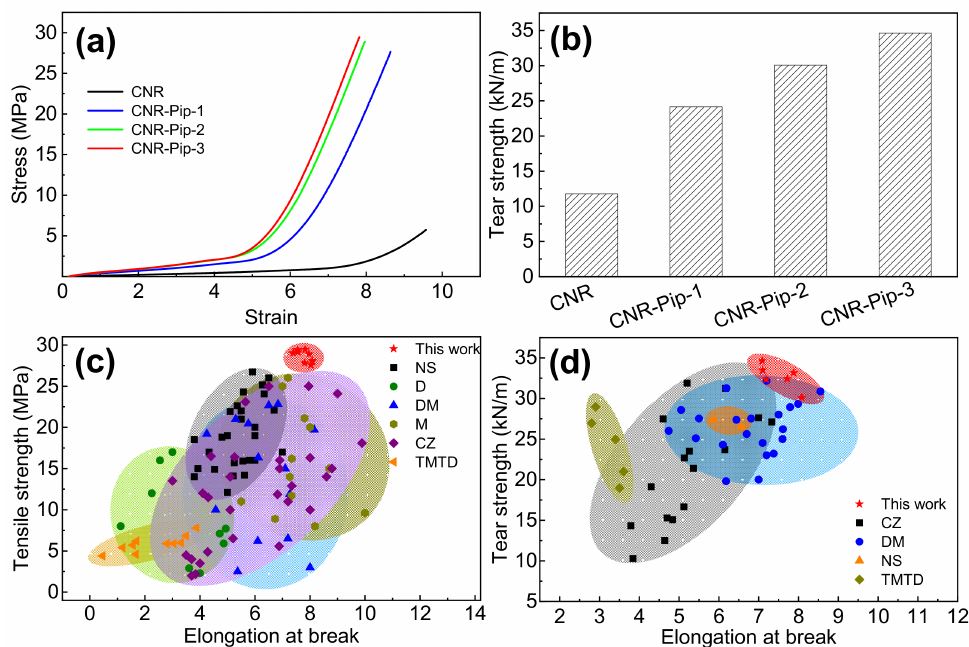
Figure 4. Changes in mechanical properties upon the addition of phase transfer agent. ( a ) Stress– strain curves of CNR, CNR-Pip-1, CNR-Pip-2, and CNR-Pip-3. ( b ) Tear strength of CNR, CNR-Pip-1, CNR-Pip-2, and CNR-Pip-3. ( c ) Comparison of tensile strength and elongation at break among this work and the elastomers with different accelerators. ( d ) Comparison of tear strength and elongation at break among this work and the elastomers with different